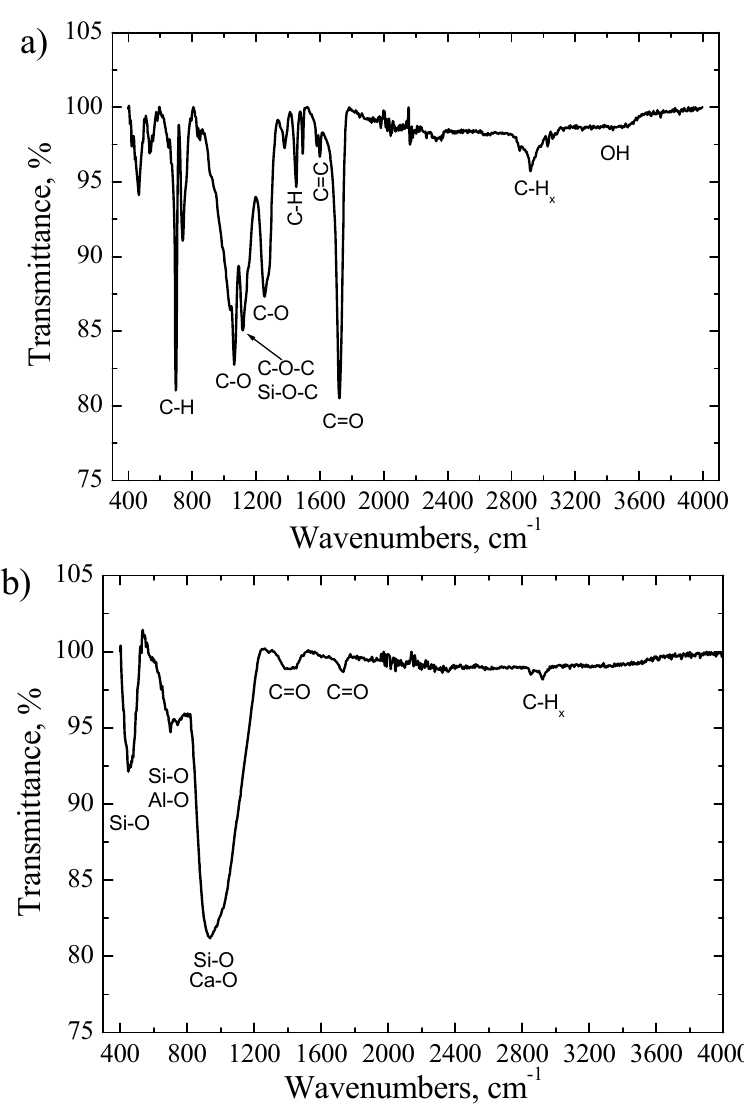
Figure 5. The FTIR transmittance spectra: ( a ) primary powder; ( b ) fiber.